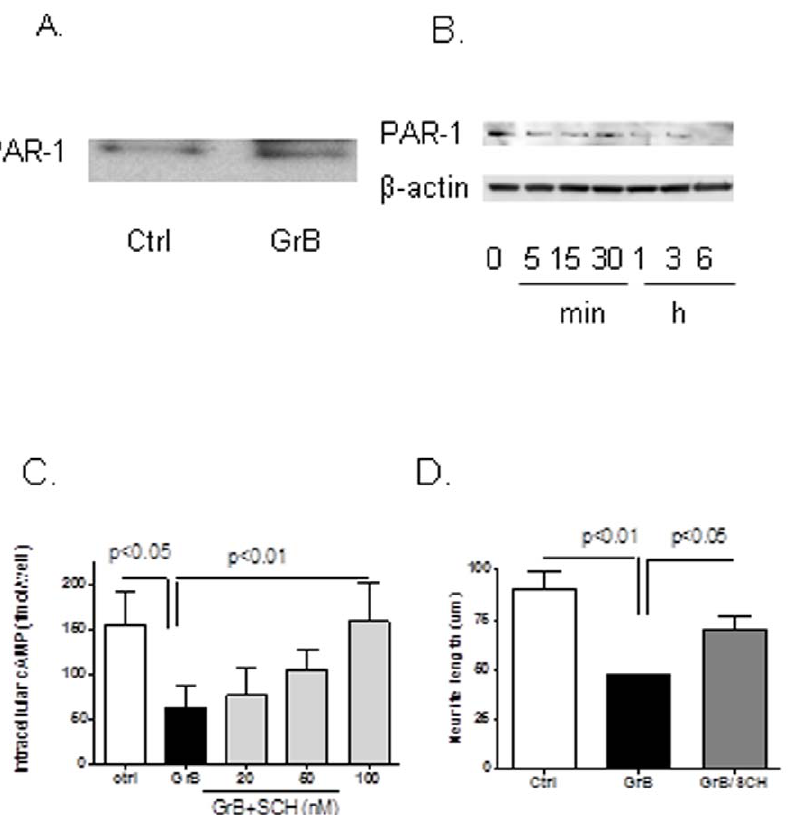
Figure 2. GrB activates PAR-1 receptor. (A) Human neuronal cells were treated with or without GrB for 30 min and then lysed with RIPA buffer. Cell lysates were incubated with GrB protein-bound protein G beads overnight at 4 u C. After washing, immunoprecipitates were resolved by SDS- PAGE and subjected to Western blot analysis using a PAR-1 specific antibody. A representative blot of three independent experiments is shown. (C) Human neurons were treated with GrB cell lysates were collected for PAR-1 detection using Western-blot analysis. A representative blot of three independent experiments is shown. GrB treatment diminished PAR-1 protein as early as 5 min following exposure, indicating that GrB may cleave the PAR-1 receptor, a classical way for PAR-1 activation. (D) Intracellular cAMP level was detected 15 min after GrB treatment in the presence and absence of SCH, a PAR-1 inhibitor. Results represent average 6 SEM from six independent experiments. (E) Effect of PAR-1 activation on GrB-induced neurotoxicity was studied by quantifying neurite length. Human fetal neurons on coverslips in 24-well plates were treated with GrB (4 nM) with or without SCH (50 nM) pretreatment. After 24 hr, neurons were immunostained for beta-III-tubulin. Average neurite lengths were measured as described in the Methods section. Results represent average 6 SEM from three independent